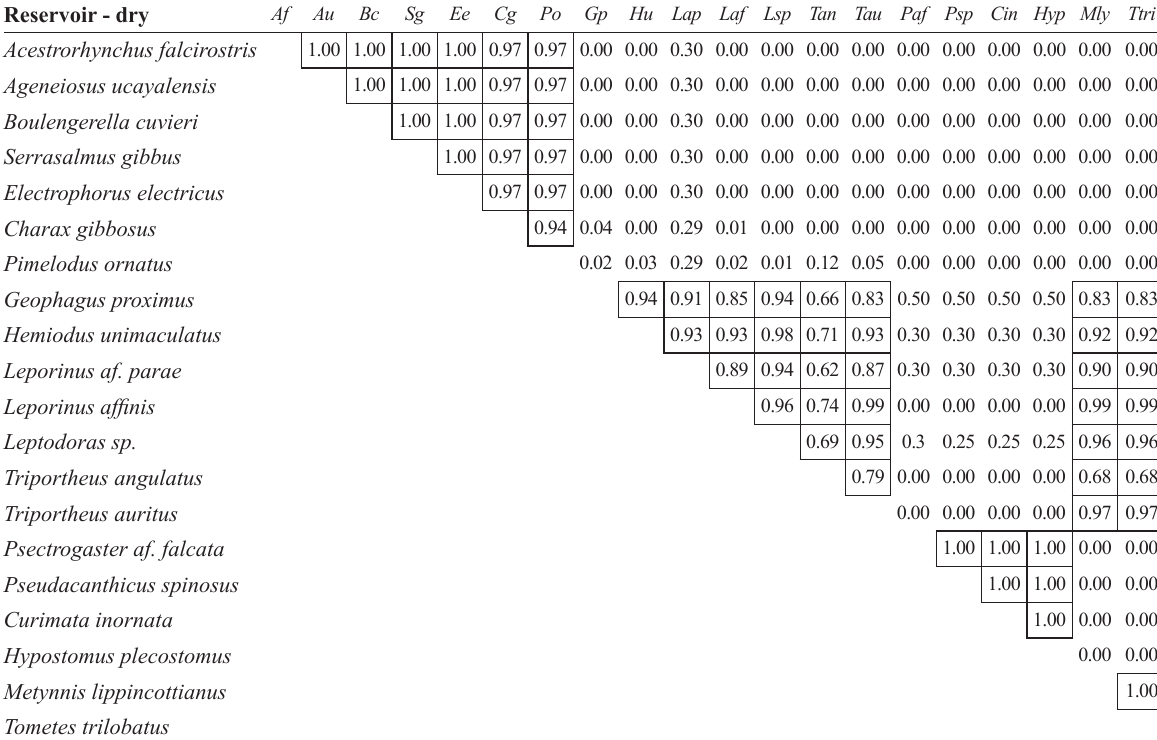
Niche overlap between pairs of species analyzed from Reservoir area of Coaracy Nunes Dam, Ferreira Gomes – Amapá (AM-Brazil).